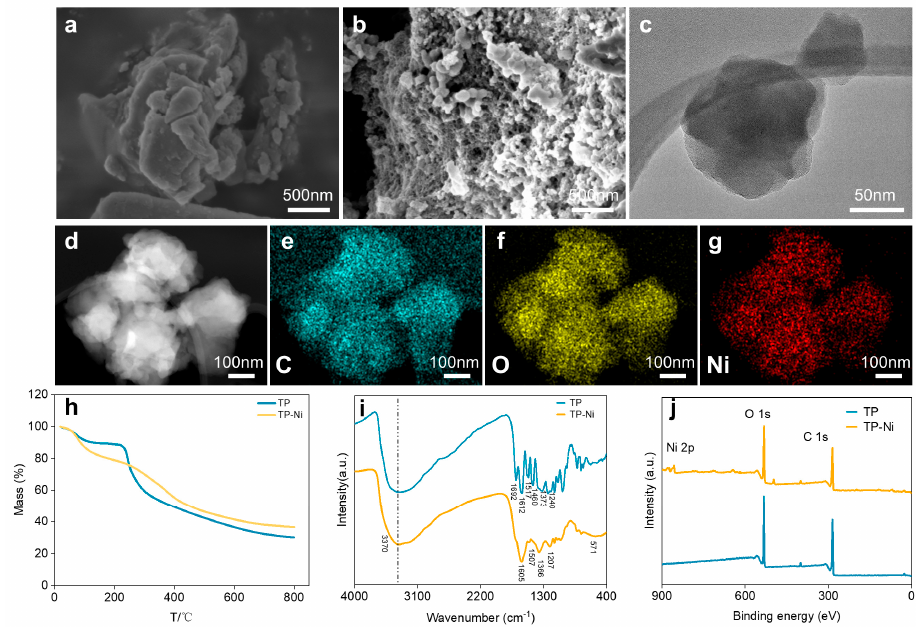
Figure 1. ( a , b ) SEM images of TP and TP − Ni, respectively. ( c ) TEM image of TP − Ni. ( d – g ) The HRTEM image of TP − Ni and the corresponding elemental mapping images of C (blue), O (yellow), and Ni (red), respectively. ( h ) TGA of TP and TP − Ni. ( i ) The FTIR spectrum of TP − Ni and TP. ( j ) The XPS pro fi le of TP − Ni and TP.